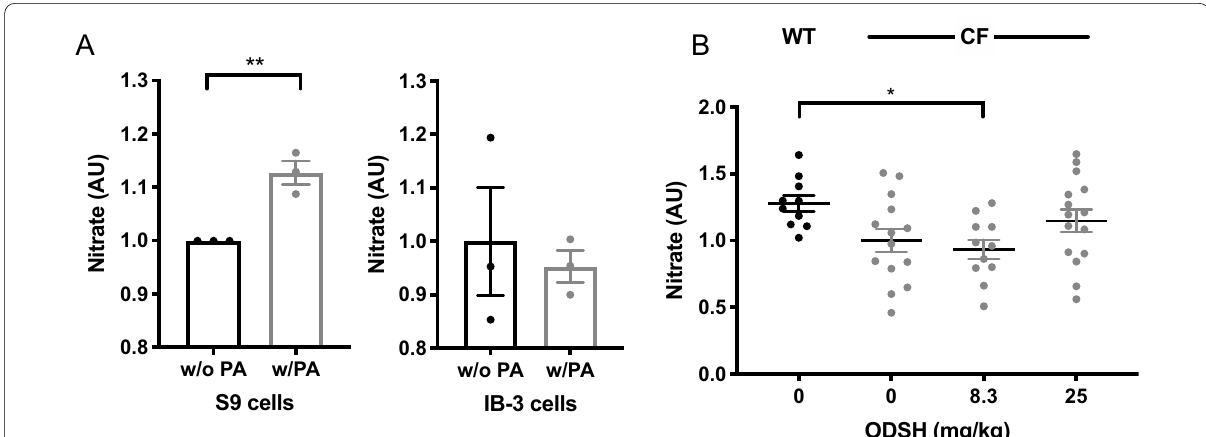
Fig. 3 ODSH increases the reduced nitrate levels in PA infected CF mice. A CFTR mutated bronchial epithelial IB3-1 cells and CFTR corrected S9 control epithelial cells were cultured with or without heat killed Pseudomonas aeruginosa (PA) at 100 µg/mL for 24 h. Cells supernatant were collected and analyzed for the levels of extracellular nitric oxide (NO) through measuring the levels of nitrate by Griess assay. Levels of nitrate were represented by relative optical density and expressed in AU. Each value represents mean SEM of three independent experiments for each group. ± **, P < 0.01 compared to the S9 control cell group infected with PA. B C57BL/6 mice (WT) and CFTR − / − mice (CF) were intratracheally inoculated with Pseudomonas aeruginosa (PA) at T 0 and were randomized to receive via i.p. administration of saline or ODSH at 8.3 or 25 mg/kg at T 0 = = and 12 h. Bronchoalveolar lavage fluid (BALF) was collected 18 h after infection (T 18 h) and the levels of NO were analyzed by measuring the = levels of nitrate by Griess assay. Values (n 10–14 mice) were represented by relative optical density and expressed in AU. Each value represents = mean SEM of three independent experiments for each group. One-way ANOVA was used for multiple group comparison and unpaired t test was ± used for two group comparison to determine statistical